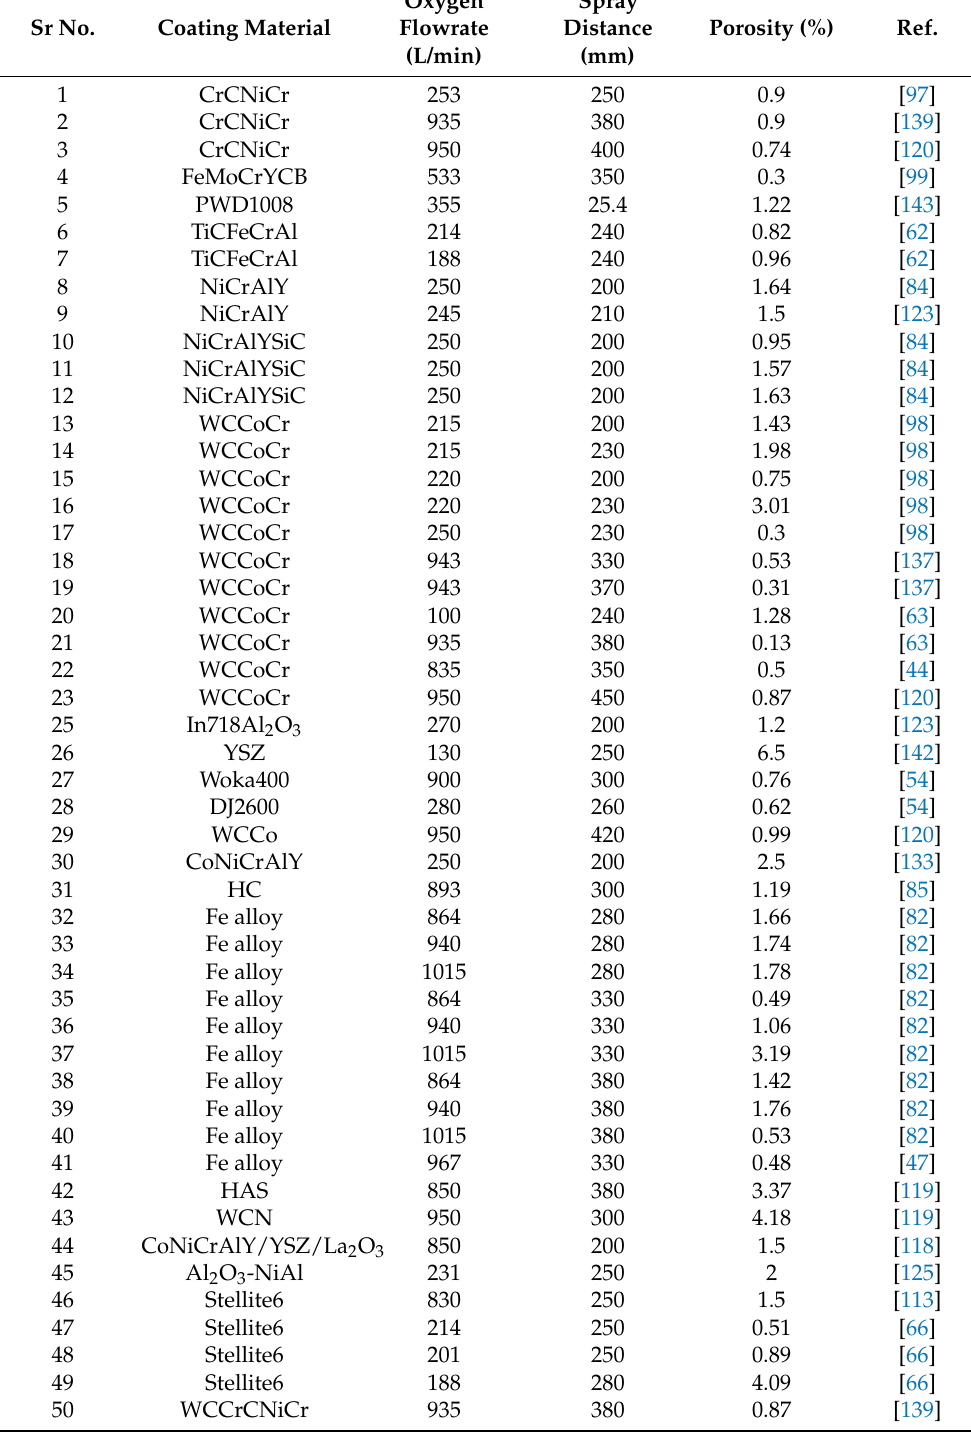
Table 3. Relation between the coating material, oxygen flowrate, spray distance, and porosity.